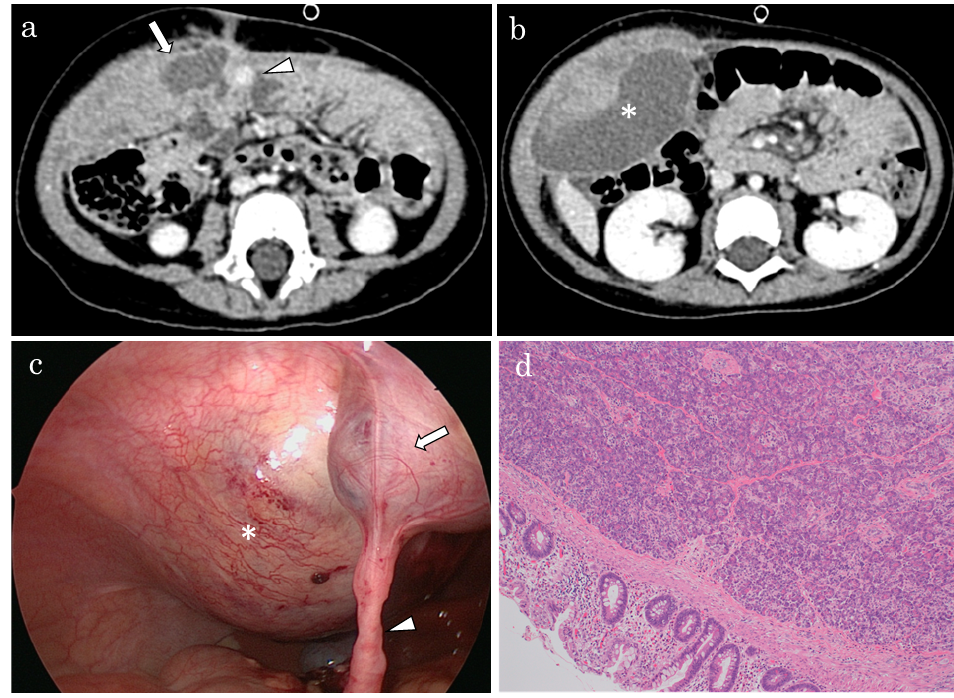
Figure 1. Contrast-enhanced computed tomography. ( a ) A 4 cm cystic lesion (arrow) located just beneath the umbilicus, containing an enhanced lesion of 1 cm in diameter (arrowhead). ( b ) On the immediate right side of this cyst, a 7 cm hematoma (*) is seen within the abdominal wall. ( c ) Laparoscopic observation reveals an omphalomesenteric cyst (arrow) beneath the umbilicus and a mesodiverticular band (arrowhead) connecting to the mesentery. These lesions are accompanied by a hematoma (*) extending to the right abdominal wall. ( d ) Pathological examination reveals that the omphalomesenteric cyst wall is lined with small intestinal and stomach mucosa, and the solid nodule contains pancreatic tissue mucosa.